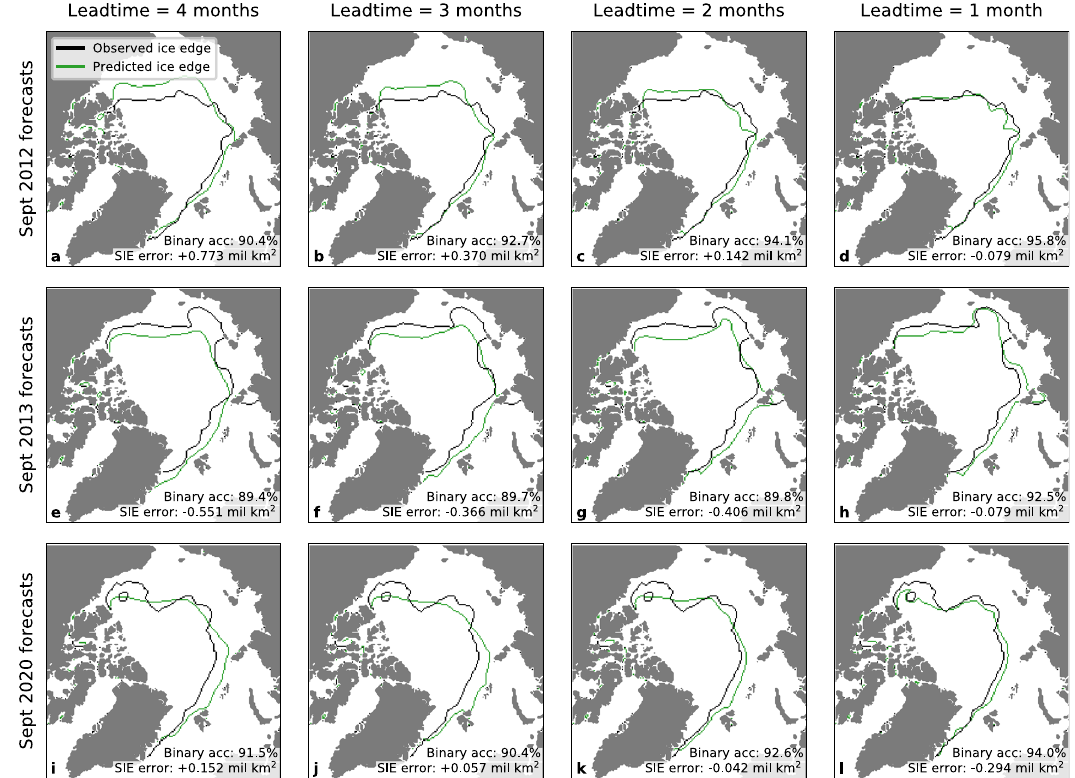
Fig. 2 IceNet ’ s ice edge forecasts for extreme September sea ice events at 4- to 1-month lead times. Forecasts are shown for September 2012 (lowest ice extent on record) ( a – d ), September 2013 (anomalously high ice extent) ( e – h ), and September 2020 (second-lowest ice extent) ( i – l ). The observed ice edge (in black) is de fi ned as the sea ice concentration (SIC) = 15% contour. IceNet ’ s predicted ice edge (in green) is determined from its sea ice probability forecast as the P (SIC > 15%) = 0.5 contour. The binary classi fi cation accuracy and sea ice extent (SIE) error is shown for each forecast (see ‘ Evaluation of IceNet ’ s performance ’ section). 2012 and 2013 are in IceNet ’ s validation dataset and 2020 is in its test Fig. 2, highlighting three anomalous events in the sea ice record.